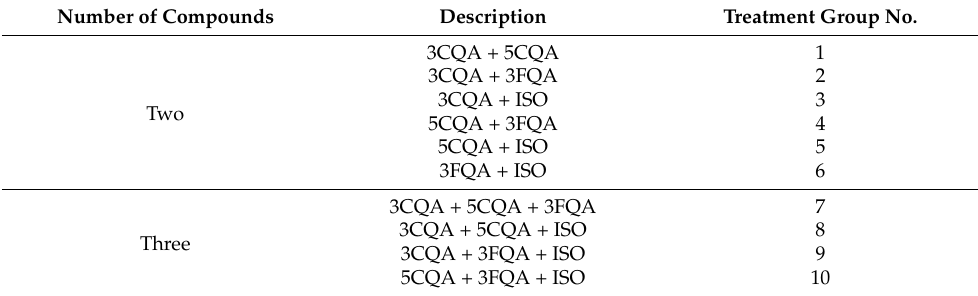
Table 1. The treatment group of combinations in this study.